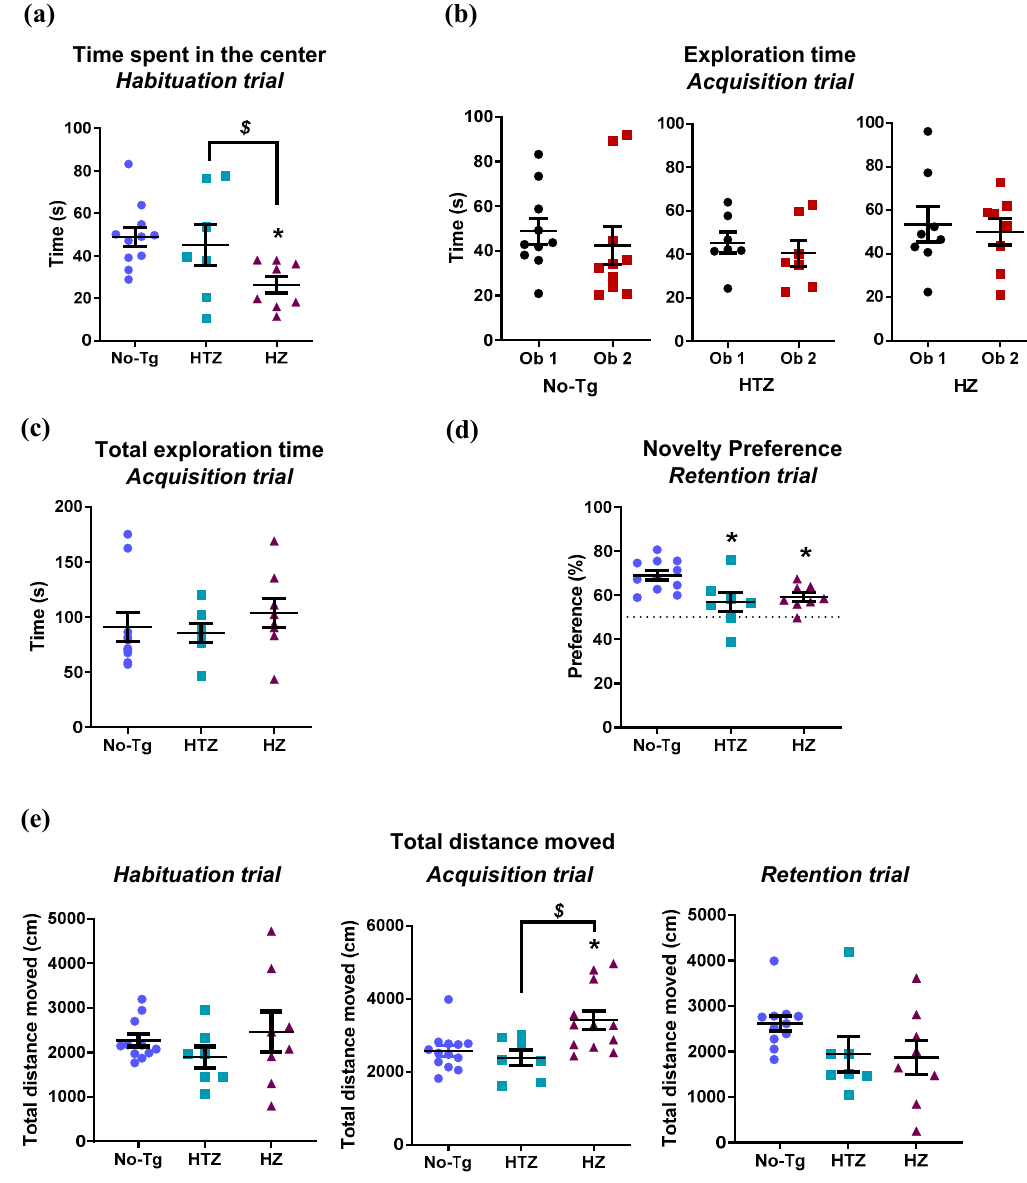
Figure 2. Impaired memory in both heterozygous (HTZ) and homozygous (HZ) 5xFAD (FAD: family Alzheimer’s disease) transgenic mice at 11 months of age on the novel recognition memory. ( a ) HZ 5xFAD mice spent less time in the center throughout the habituation trial. No differences were found ( b ) in exploring both objects or ( c ) in the total exploration time. ( d ) Both HTZ and HZ 5xFAD mice exhibited impaired memory in the retention trial. ( e ) There were no differences in locomotion between genotypes in the habituation and retention trial, but HZ 5xFAD mice exhibited hyperactivity in the acquisition trial compared to No-Tg and HTZ. One-way ANOVA and Tukey’s test were performed: (*) p < 0.05 vs. nontransgenic wild-type (No-Tg) group; ($) p < 0.05 between HTZ and 5xFAD group. All data are displayed as the mean ± standard error of the mean (SEM).